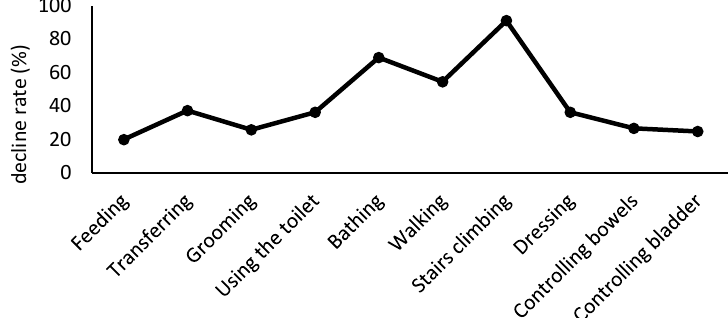
Figure 2. Subitems of reduced BI scores in patients with HAD ( n = 104). Patients with declines in multiple subitems were included. BI: Barthel Index.